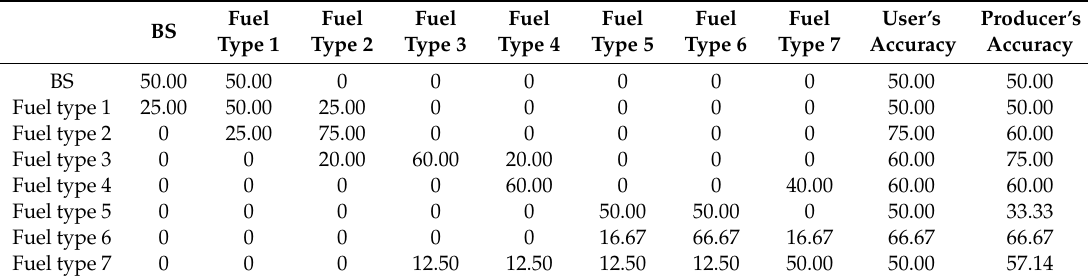
Table 8. Confusion matrix for the most accurate classification model using ALS data after validation. Values are showed in %. BS stands for bare soil.